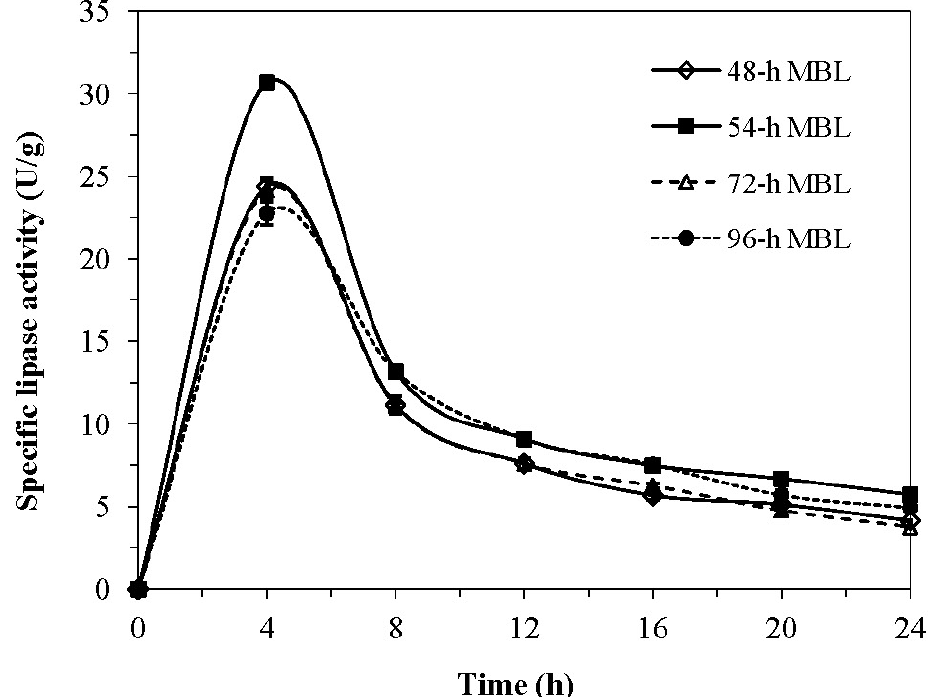
Figure 1. Activity profile as a function of time of MBL harvested at different growth intervals of G. candidum . Cultivation was performed at 30 °C in 1 L shaken broth inoculated with 2% (v/v) 24-h seed culture and 2% (w/v) sterilised palm